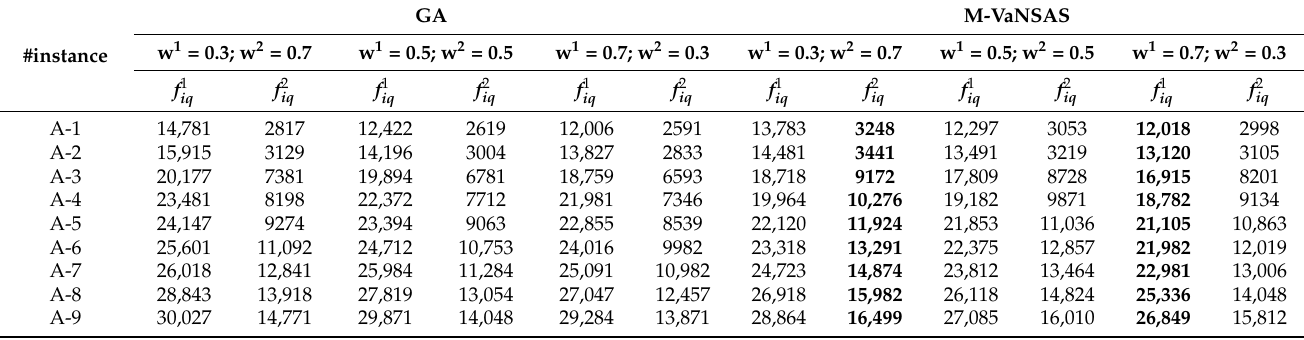
Table 10. Computational results of all 14 test instances when varying w 1 and w 2